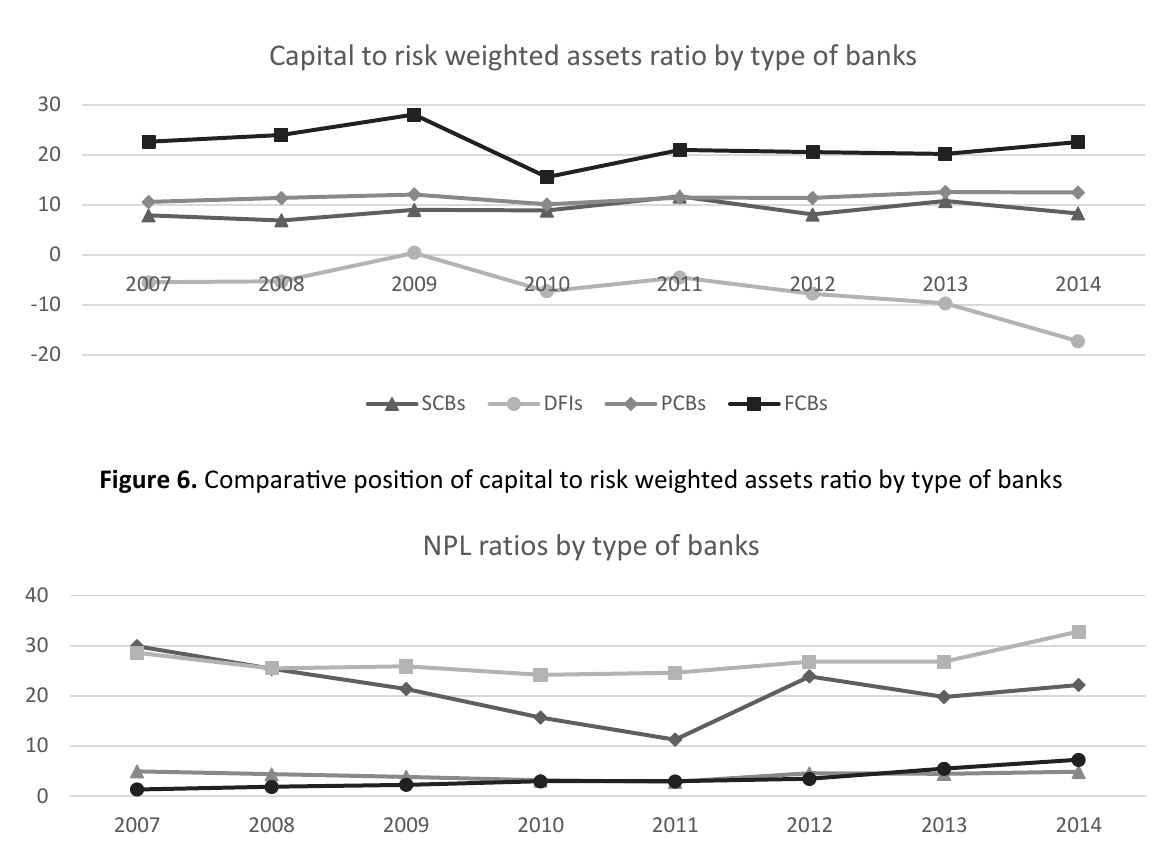
Figure 5. Comparative position of the structure of the banking system